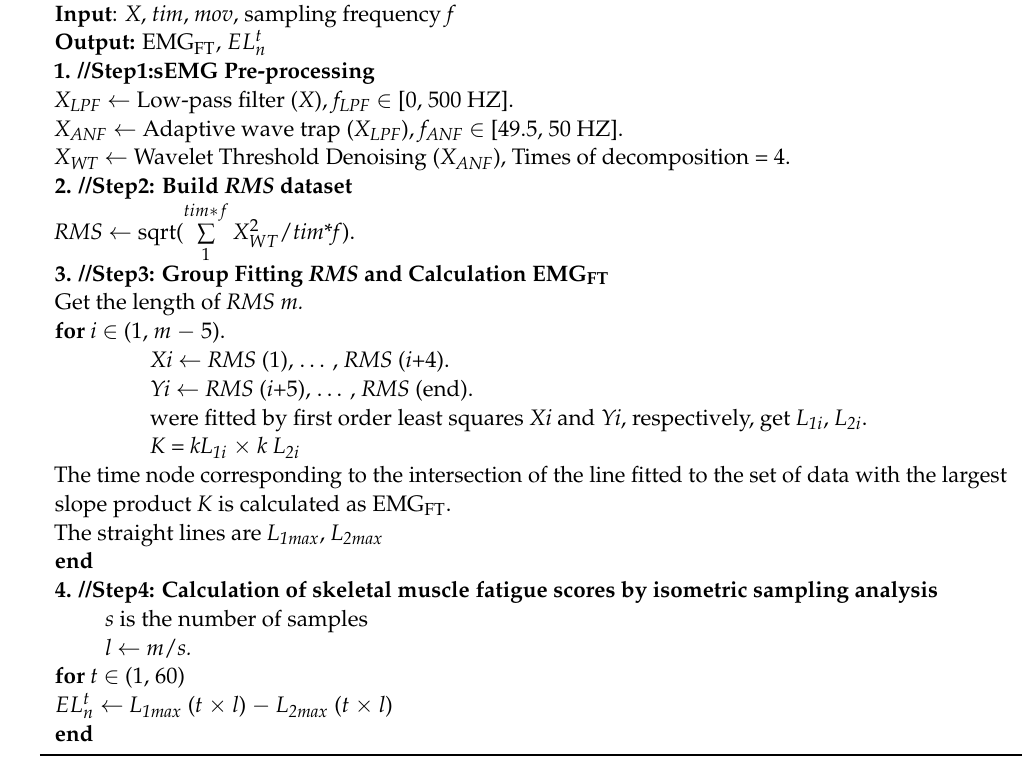
Algorithm 1: Improved EMG FT fatigue level determination algorithm